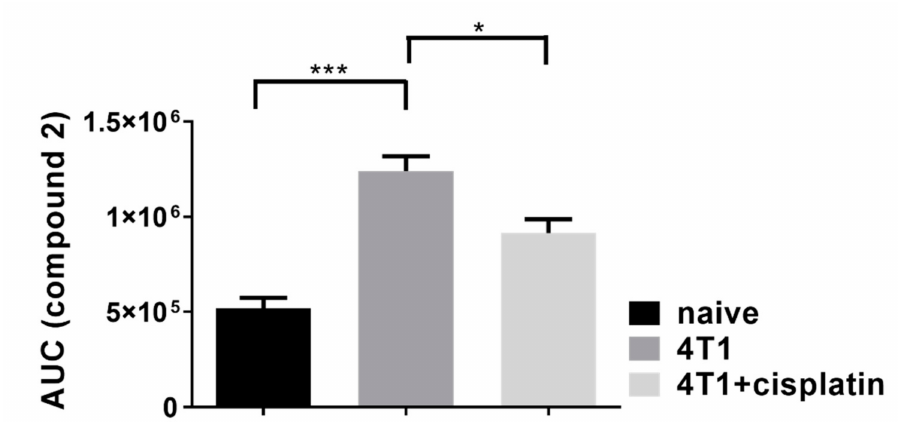
Figure 3. The proteolytic activity of the fibroblast activator protein (FAP) increased by the formation of breast cancer, and was significantly decreased by cisplatin treatment. Area under the curve (AUC) values from high pressure liquid chromatography (HPLC) analysis of the peptide digestion product 2 (Figure S2) were plotted. The results are shown as arithmetic mean values of the samples ± standard error of the mean (SEM), statistical significance was set to *** p < 0.001, * p <